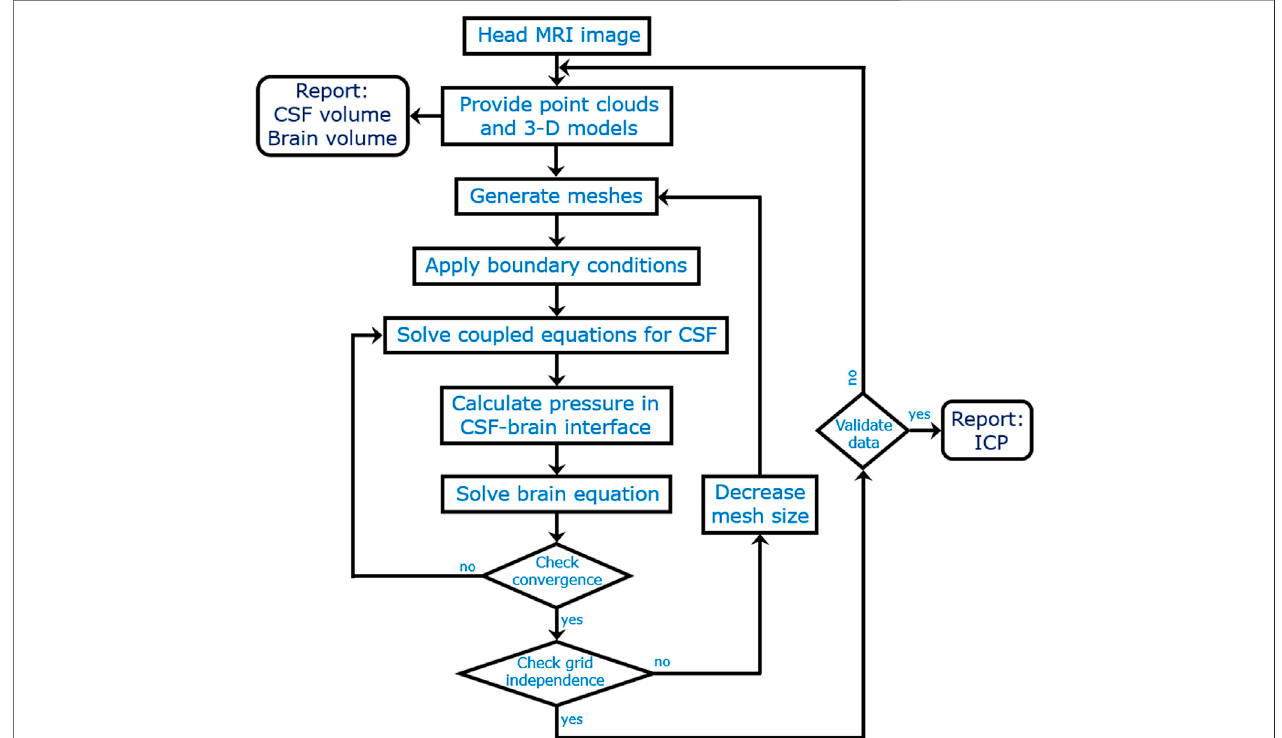
FIGURE 1 | The methodological work fl